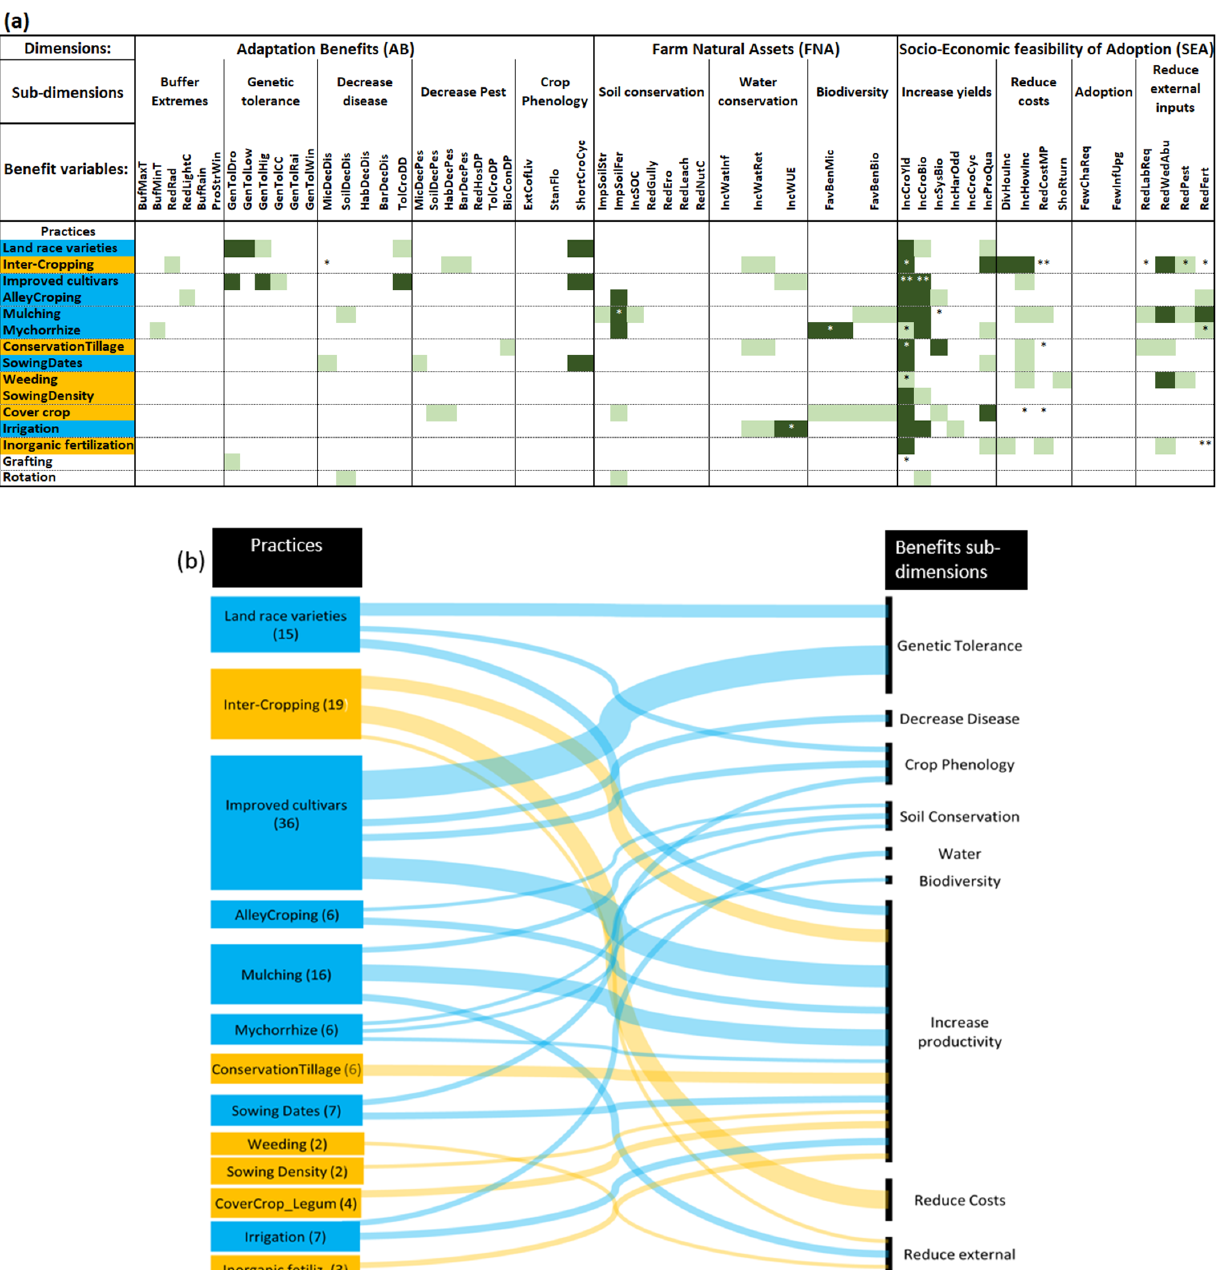
Figure 4. ( a ) Table of records ( n = 186) and knowledge gaps regarding the effects of agricultural practices (first column) on multiple benefits organized by the benefit dimensions and sub-dimensions relevant for bean smallholders' adaptation. Cells in the table show where we found no record of positive effect (empty cells); only one record (light green), two or more records (darker green). For record of negative effects, the table show only one record one (*) or two or more records (**). ( b ) Sankey evidence synthesis diagram ( n = 129) visually display the benefits provided by those practices for which at least two or more records confirm their positive effects (i.e., darker green cells in the accompanying table).